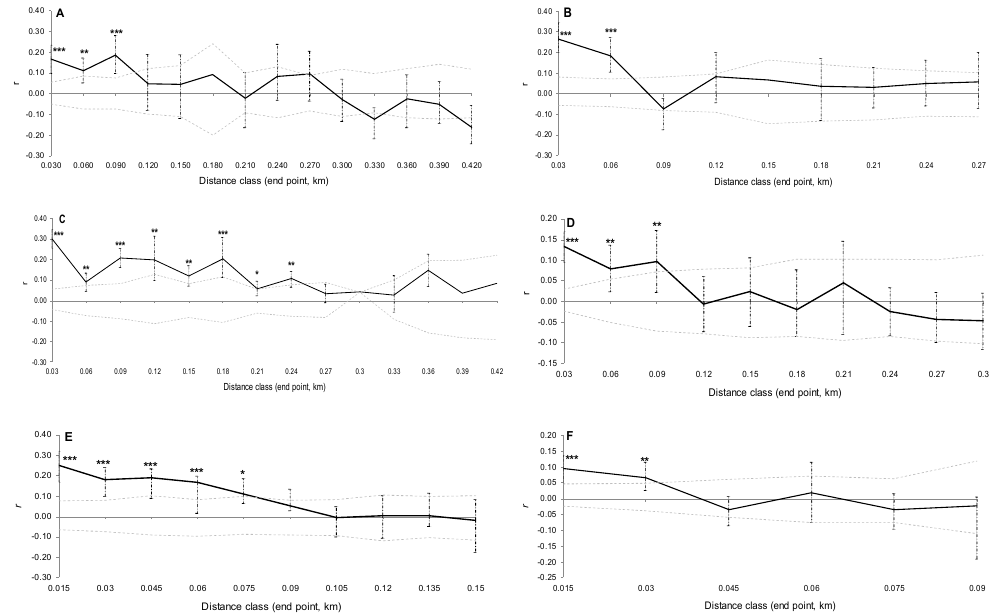
autocorrelation over the first eight distance classes (0–240 m).